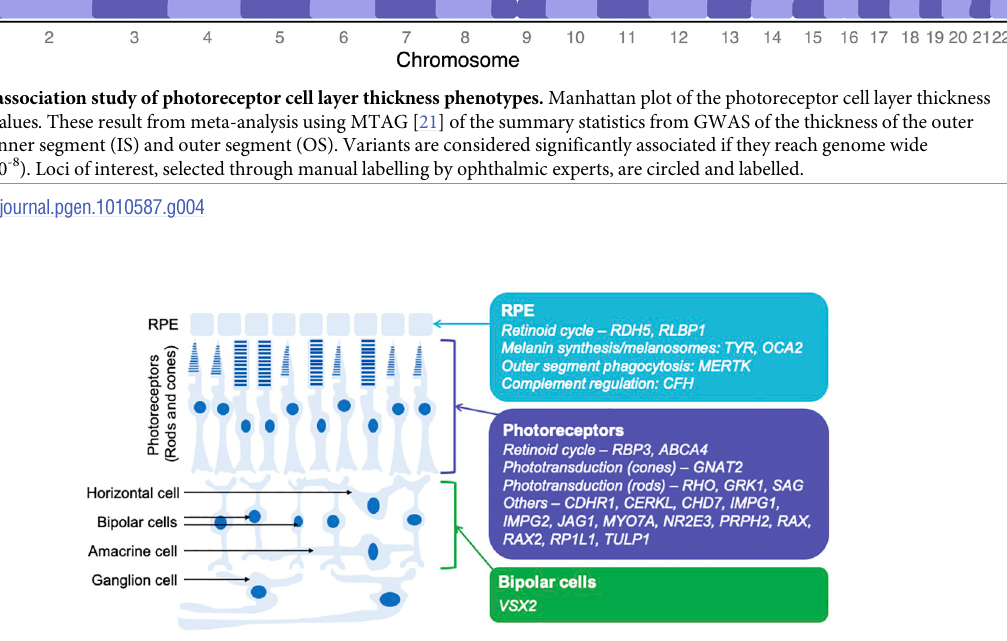
PLOS Genetics | https://doi.org/10.1371/journal.pgen.1010587 February 27,